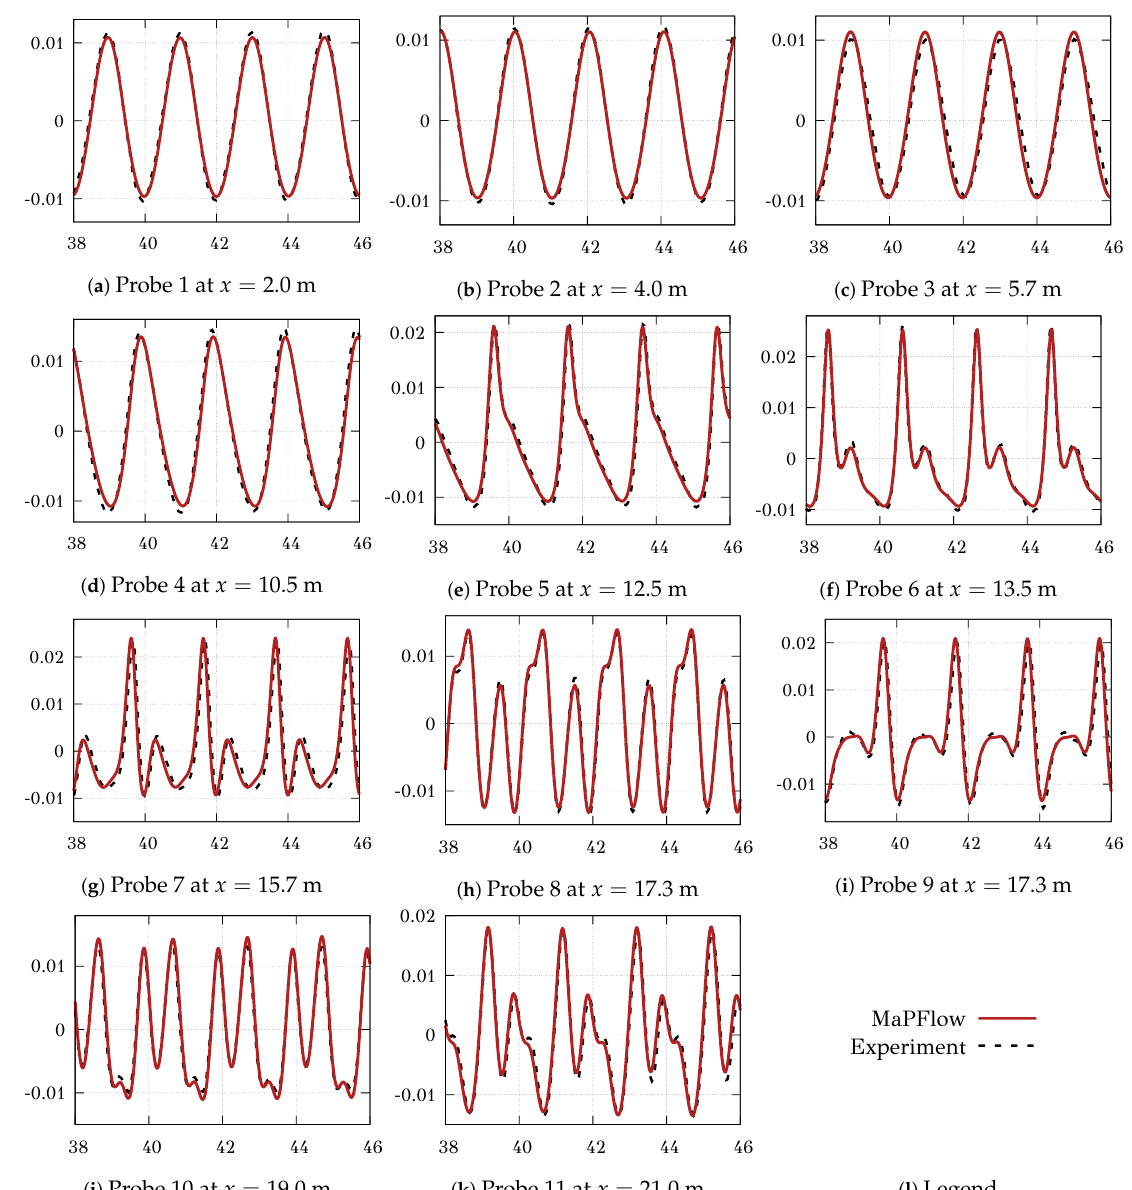
Figure 8. Free surface elevations at the wave probes. Comparison of the numerical results and experimental data (probes